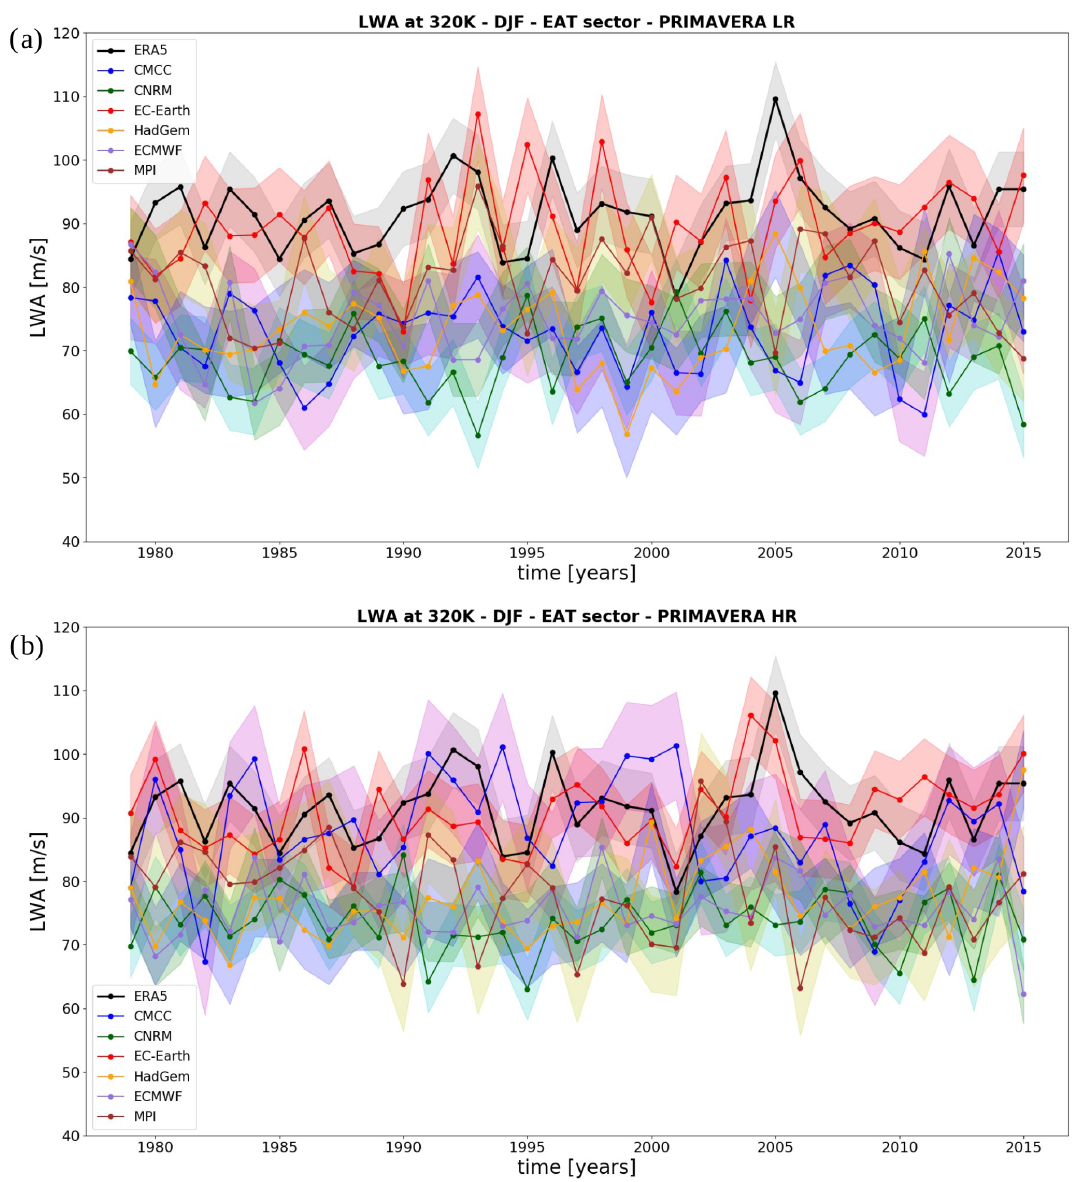
Figure 12. As in Fig. 9 but for the EAT